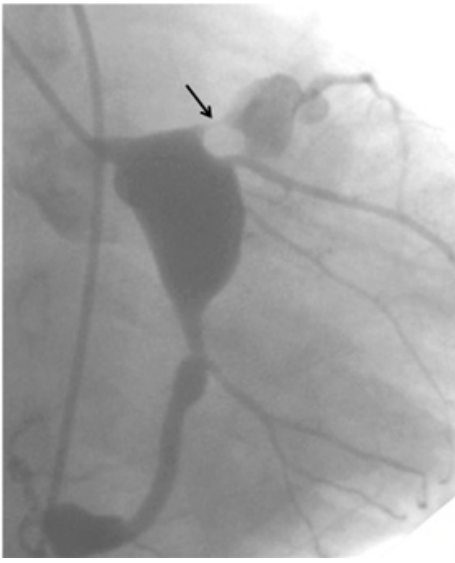
Figure 1. Selective coronary angiogram of the left coronary artery before operation. A seven-year-old Serbian girl who had had Kawasaki disease (KD) at infancy developed localized tight stenosis just at the proximal portion of the left anterior descending artery.